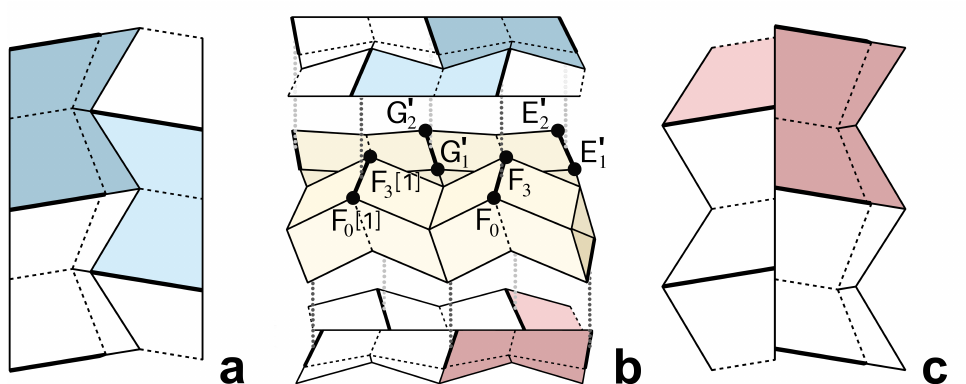
Figure 4. ( a ) The top smooth sheet attachment ( S 1 is lightly shaded, S 4 is darkly shaded, and co- planar ridges are bolded). ( b ) Adding the top and bottom smooth sheet attachments to asymmetric zipper-coupled tubes (co-planar ridges are bolded). ( c ) The bottom smooth sheet attachment ( S 3 is lightly shaded, S 2 is darkly shaded, co-planar ridges are